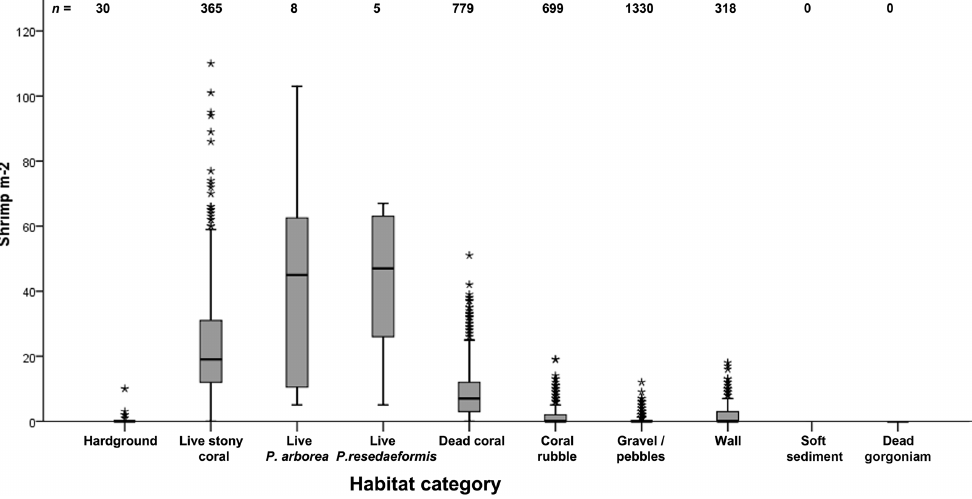
Fig. 7. Densities of shrimp in images containing 2, 3 or 4 + microhabitat categories were not significantly different from each